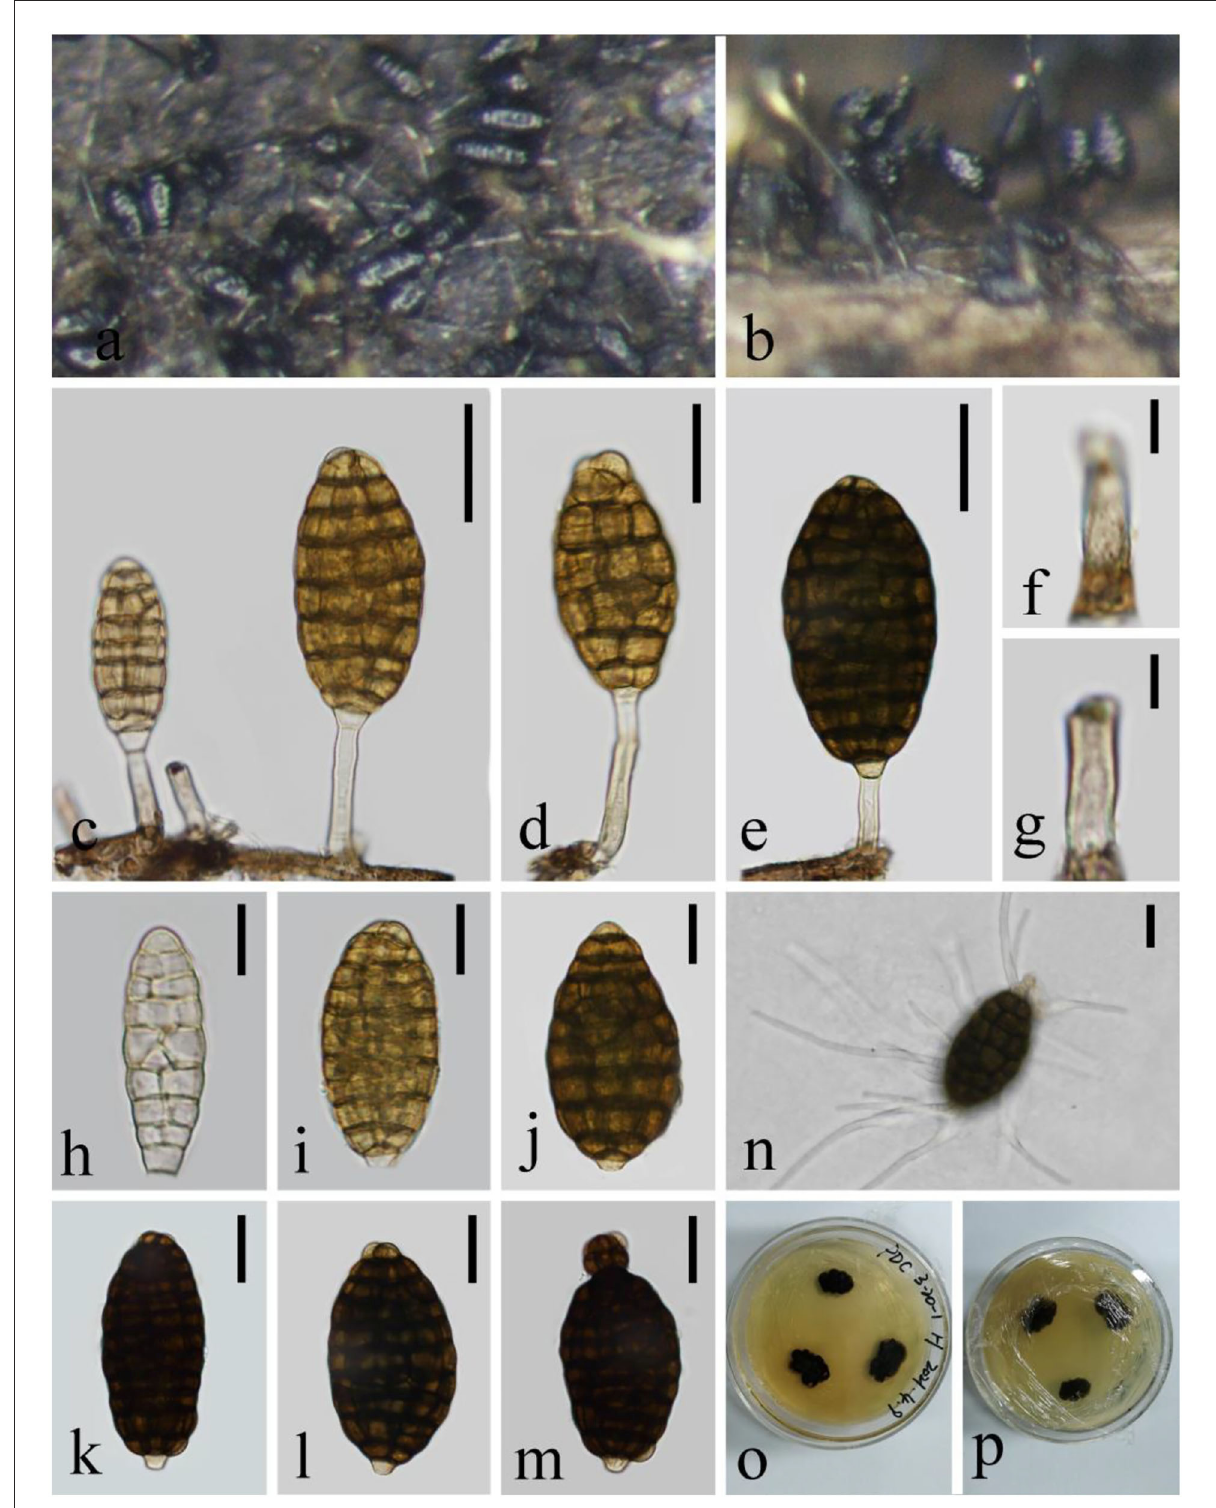
FIGURE5 Neomanoharachariella aquatica (KUN-HKAS 124611, holotype). (a,b) Colony erect on decaying wood. (c–e) Conidiophores with attached conidia. (f,g) Conidiogenous cells. (h–m) Conidia. (n) Germinating conidium. (o,p) Culture on PDA. Scale bars: (c,e) 25 µ m, (f,g) 5 µ m, (h–j) 15 µ m, and (d,k–n) 20 µ